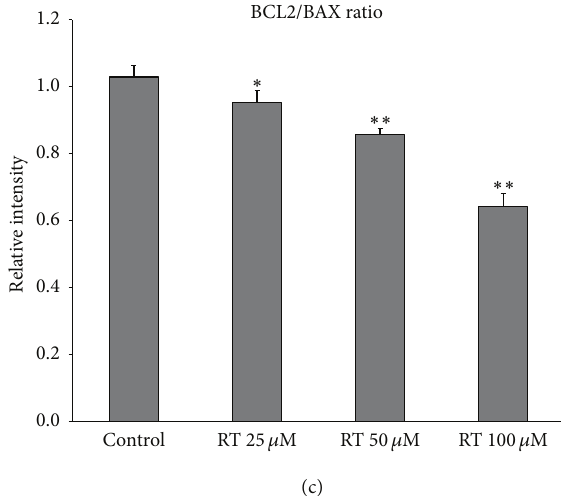
Figure 4: The effect of rutin on cell apoptosis and expression of BCL2 and BAX. (a) Apoptosis rates of LAN-5 incubated with different concentrations of rutin, the percentage of apoptotic cells were measured by flow cytometry using the PI-annexin V assay. (b) Quantification of BCL2 and BAX mRNA levels, (c) calculated BCL2/BAX ratios. The “relative intensity” was defined as the intensity (target mRNA)/intensity (GAPDH). All experiments were repeated three times. ∗ 𝑃 < 0.05 , ∗∗ 𝑃 < 0.01 compared to control. 1: marker; 2: control; 3: RT 25 𝜇 M; 4: RT 50 𝜇 M; 5: Rt 100 𝜇 M.